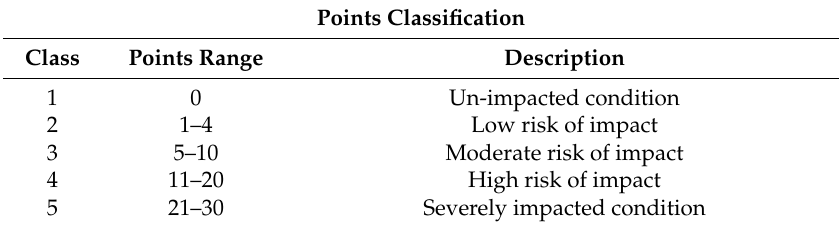
Table 3. Definition of DHRA method